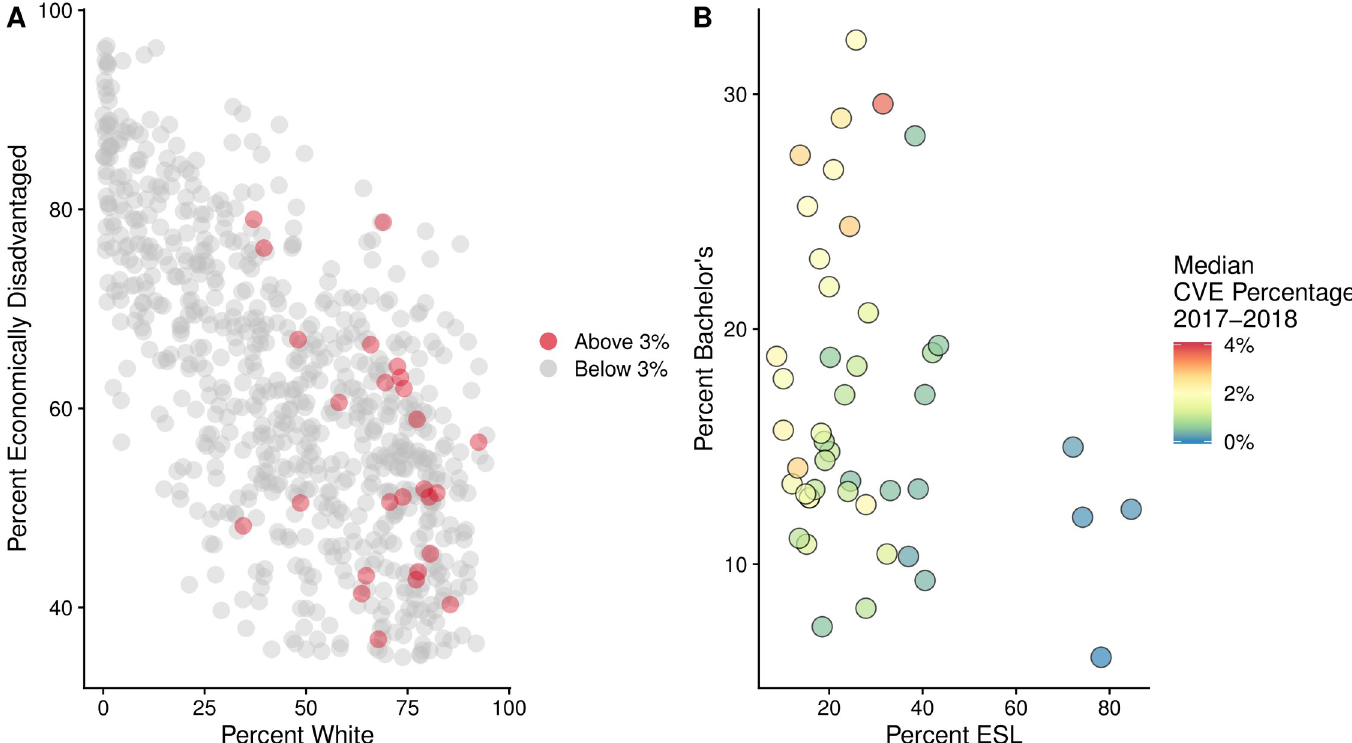
Fig 2. Socioeconomic correlates of CVE percentages. A: The percentage of the school system population that self-reports as ethnically white and the percentage of students in the school system reported as economically disadvantaged are significant predictors of CVE percentages in public school systems (Table 1). Each point represents a public school system in Texas. Red indicates schools with CVE percentages of at least 3%. B: The percentage of a county population with bachelor’s degrees and the percentage that speak English as a second language are both significant predictors of median CVE percentages within counties (Table 1). Each point represents a county in one of Texas’s 10 largest metropolitan areas. Color reflects the median 2017–2018 CVE percentage within each county, across all public, private, and charter school systems. CVE, conscientious vaccination exemption; ESL, English as a second